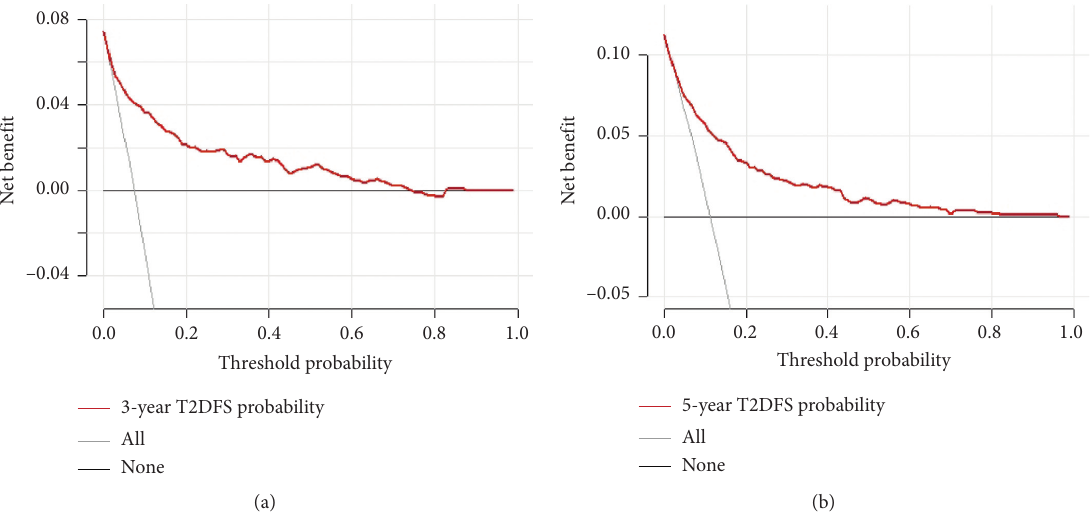
Figure 5: Decision curve analysis for the nomogram for predicting T2DFS in validation set. Notes: decision curves for T2DFS at 3years (a) and 5years (b) were applied to the nomogram. The y -axis measures the net benefit. The red line represents the nomogram. The thin solid line represents the assumption that all subjects are non-T2DFS. Thin thick solid line represents the assumption that all subjects are